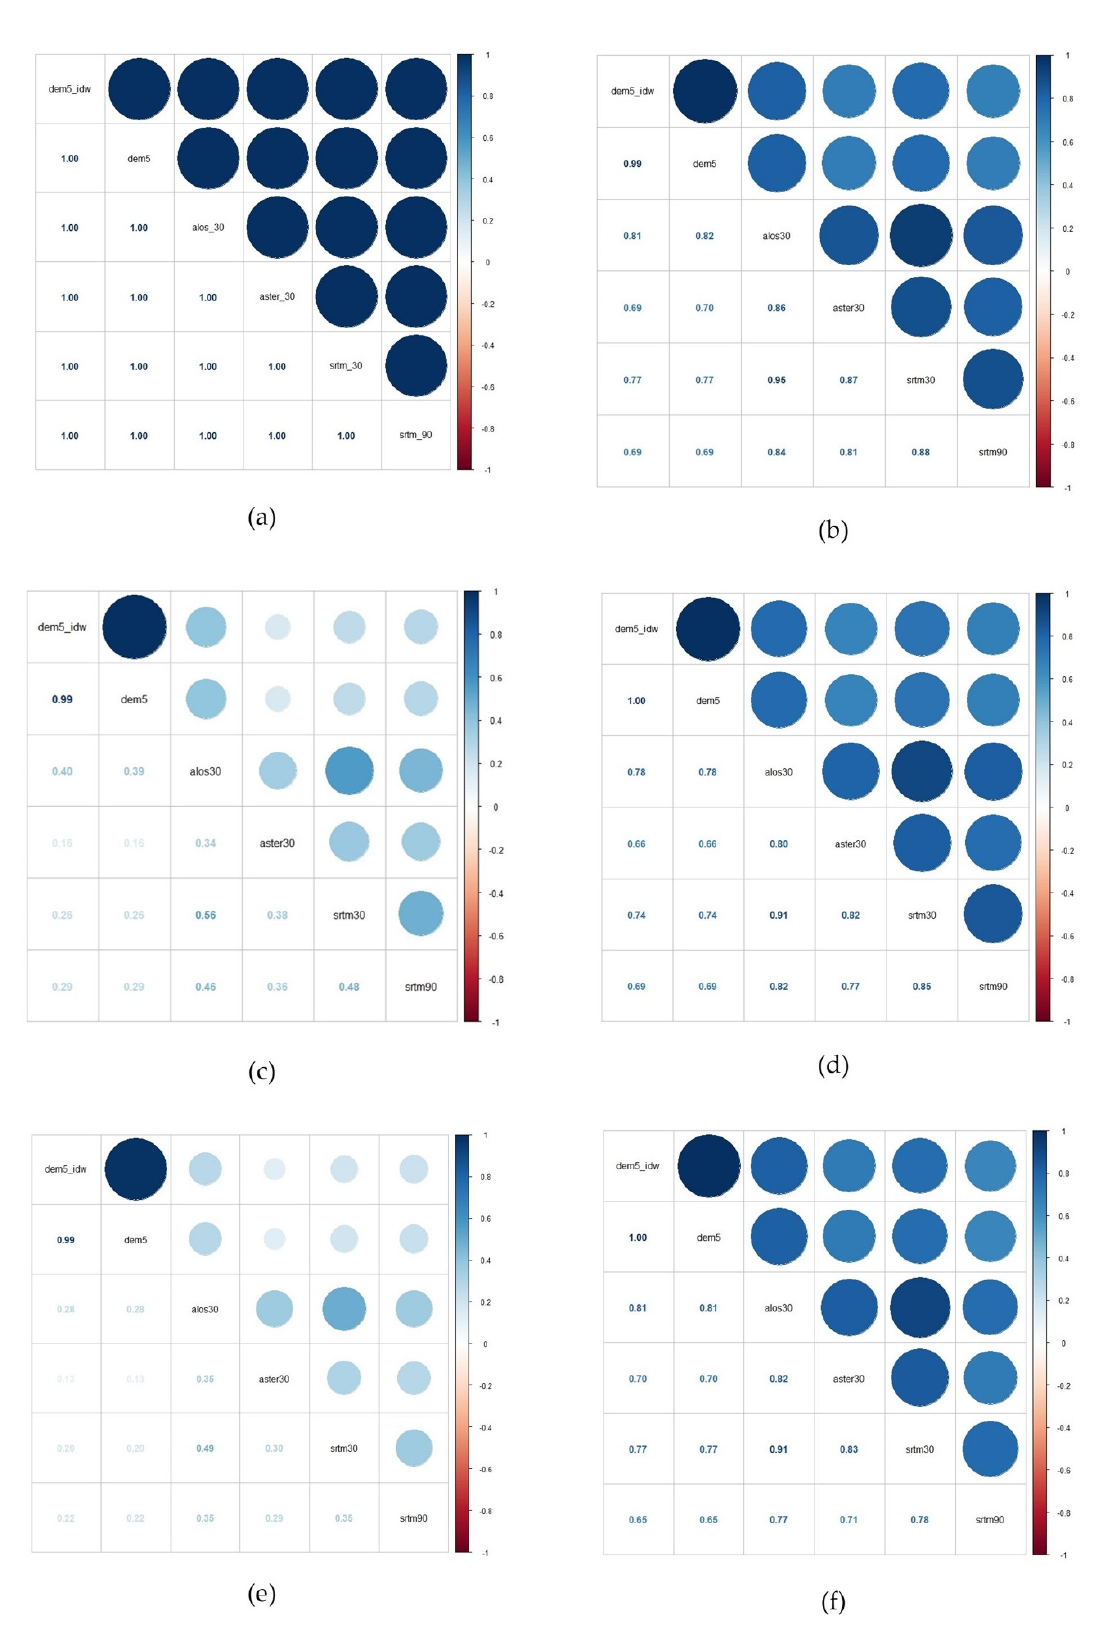
Figure A3. Pearson correlation charts of ( a ) DEM, ( b ) Slopes, ( c ) LS from MIT method, ( d ) LS from CAL method, ( e ) SE from MIT method and ( f ) SE from CAL method.